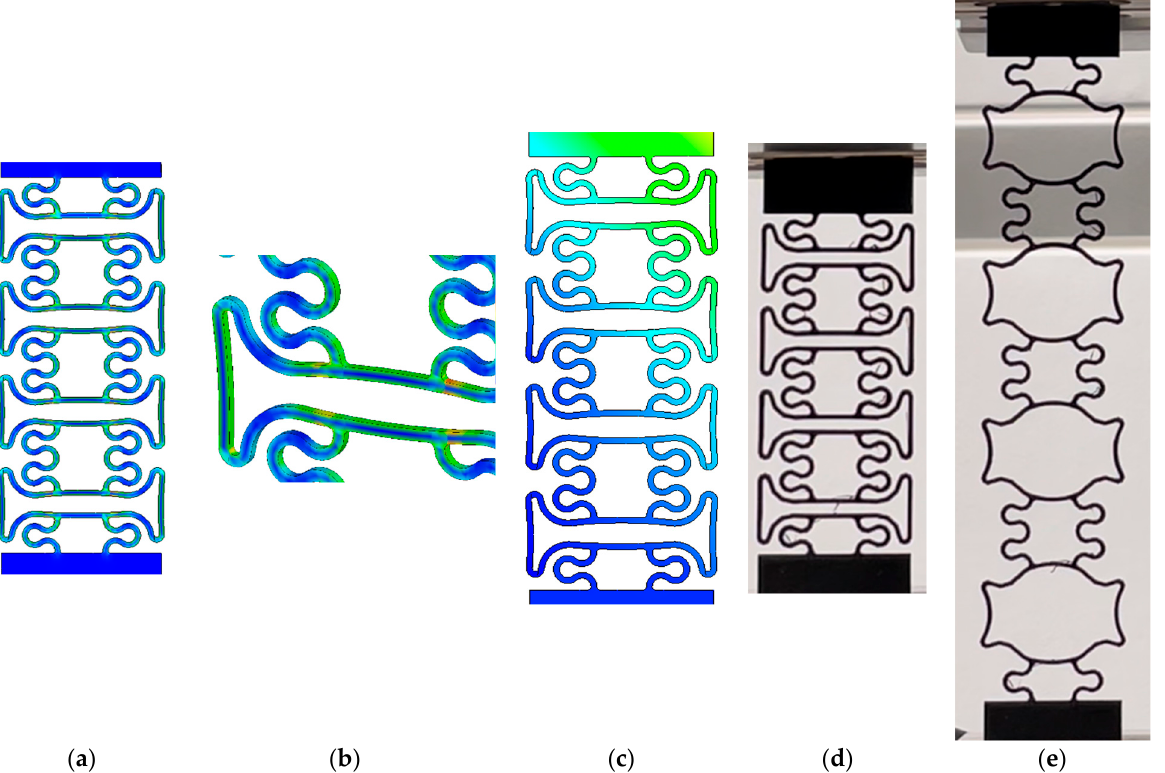
Figure 11. KH structure with FEA, unstretched length, and stretched length: ( a ) FEA stress analysis, ( b ) FEA close-up for stress concentration, ( c ) FEA displacement, ( d ) printed structure, ( e ) stretched printed structure.